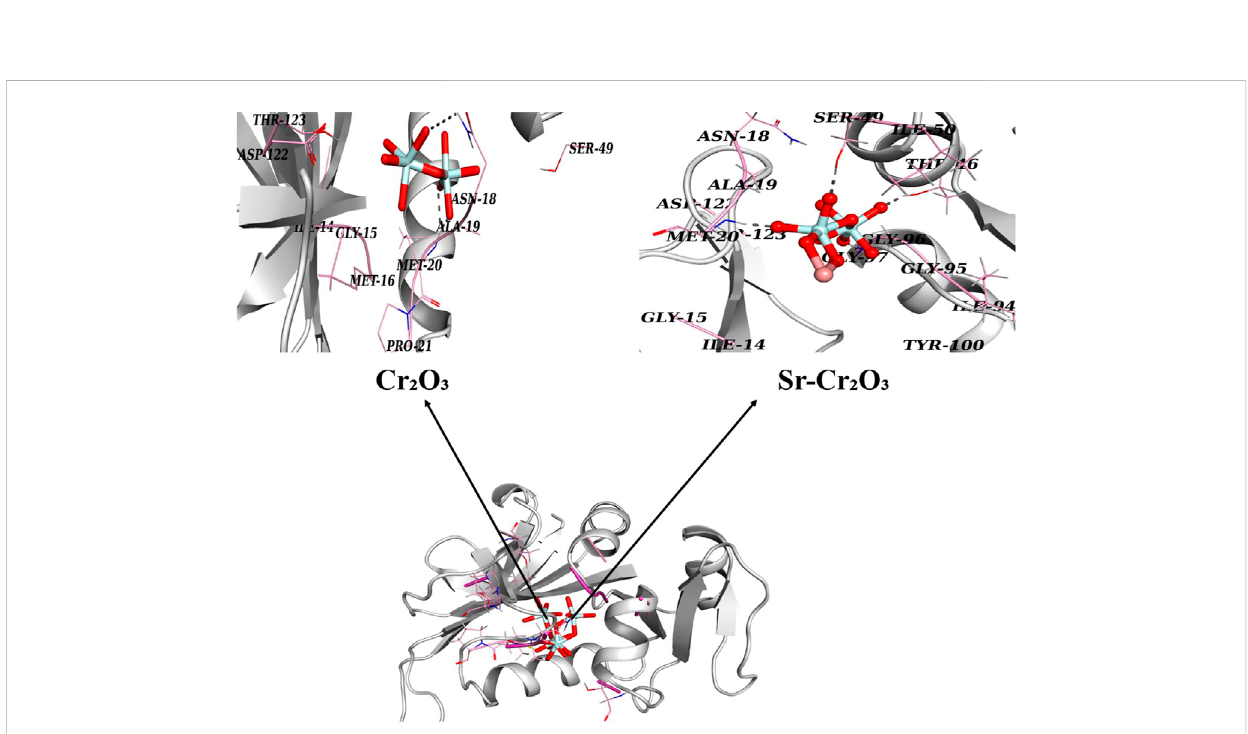
FIGURE 12 3D graphical representation of binding interaction patterns of Cr 2 O 3 and Sr-doped Cr 2 O 3 nanocomposites inside active pockets of DHFR from E. Coli (DHFR E. Coli ).